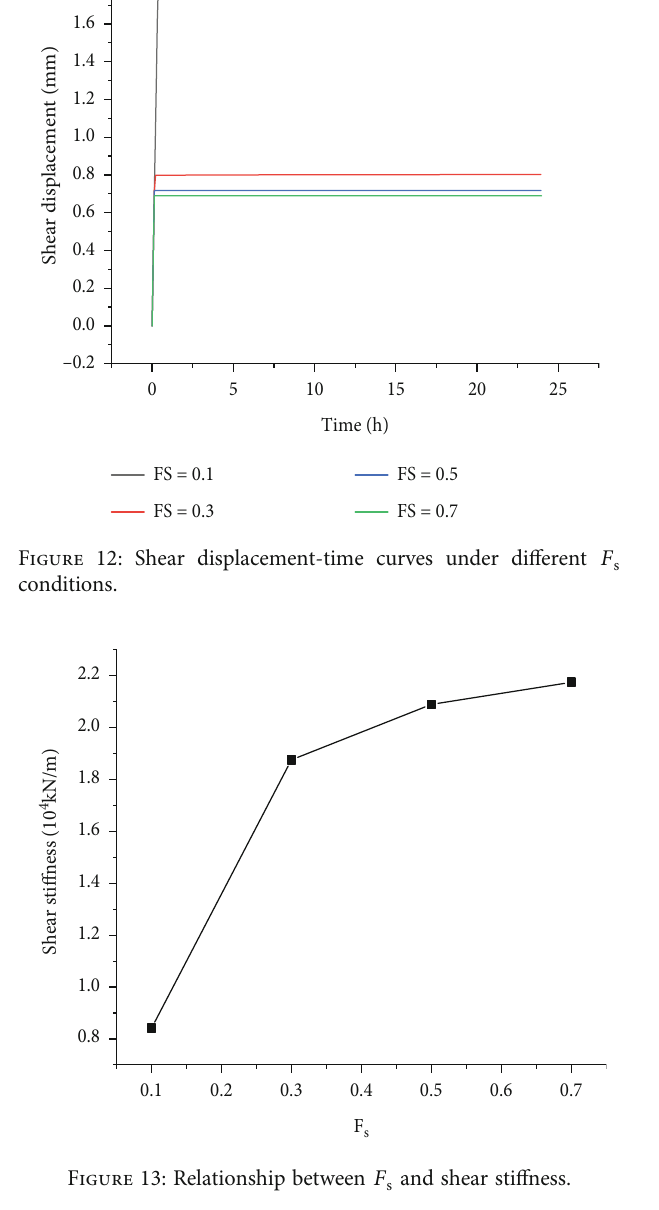
Figure 13: Relationship between F